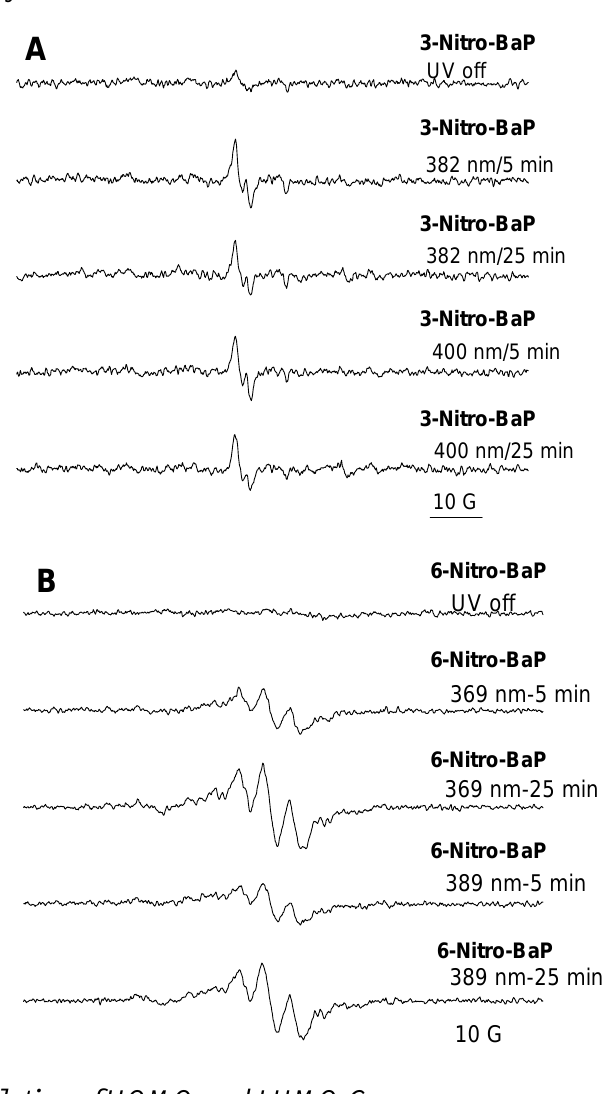
Figure 8. The generation of substrate-derived free radicals from ( A ) 3-nitro-BaP and ( B ) 6-nitro-BaP. Samples contained 0.9 mM 3-nitro-BaP or 6-nitro-BaP and 25 mM 5- tert -butoxycarbonyl-5-methyl-1-pyrroline- N -oxide (BMPO) in 90% CH were irradiated at 382 and 400 nm for 3-nitro-BaP; and 369 and 389 nm for 6-nitro-BaP. ESR signal recorded after 5 and 25 min time intervals. ESR instrument settings were as follows: 20 mW microwave power, 100 G sweep width, 1 G field modulation amplitude, and 100 kHz modulation